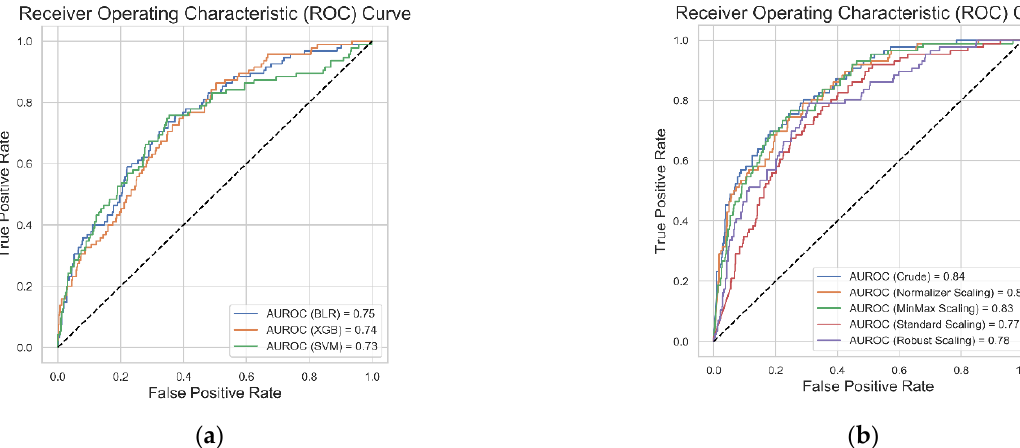
Figure 3. Result of the receiver operating characteristic curve of binary logistic regression, extreme gradient boosting, and support vector machine algorithms ( a ) and the artificial neural network algorithm before and after input parameter scaling ( b ). BLR: binary logistic regression; XGB: extreme gradient boosting; SVM: support vector machine; ANN: artificial neural network; and AUROC: area under the receiver operating characteristic curve.